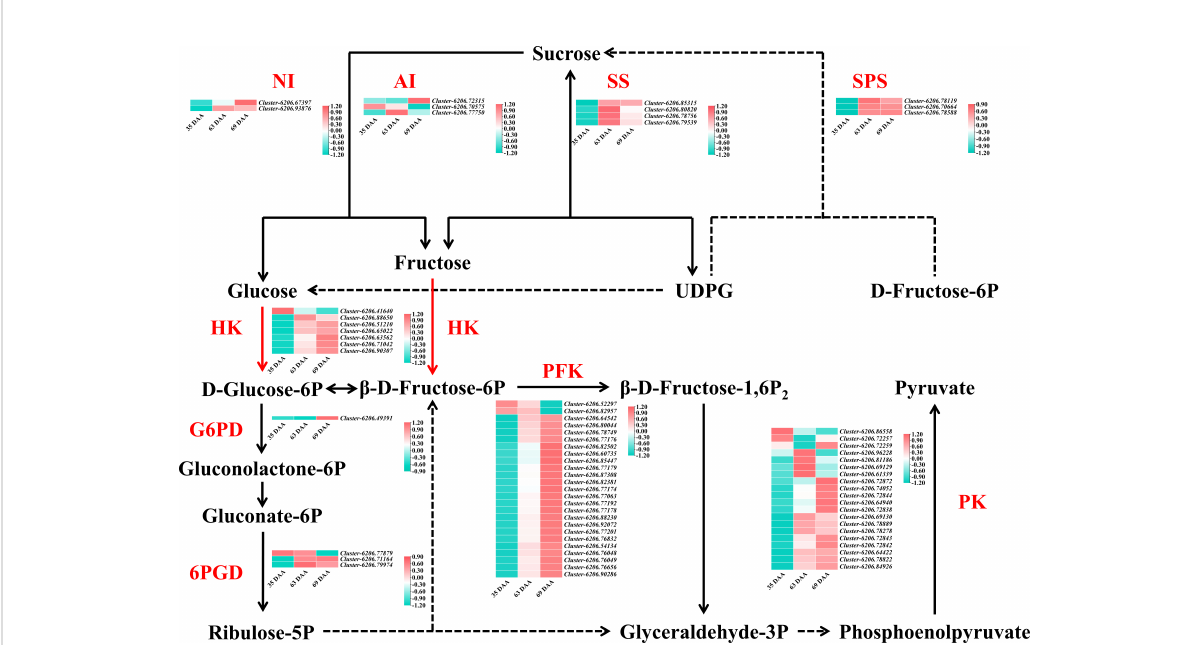
FIGURE 6 The sugar metabolism pathway map and heatmap of differentially expressed genes in 35 d vs. 63 d, 63 d vs. 69 d, 35 d vs. 69 d. The color bar represents the value of log 2 (fold change). SS, sucrose synthase; SPS, sucrose phosphate synthase; AI, acid invertase; NI, neutral invertase; HK, hexokinase; G6PD, glucose 6-phosphate dehydrogenase; 6PGD, 6-phosphogluconate dehydrogenase; PFK, phosphofructokinase; PK, pyruvate